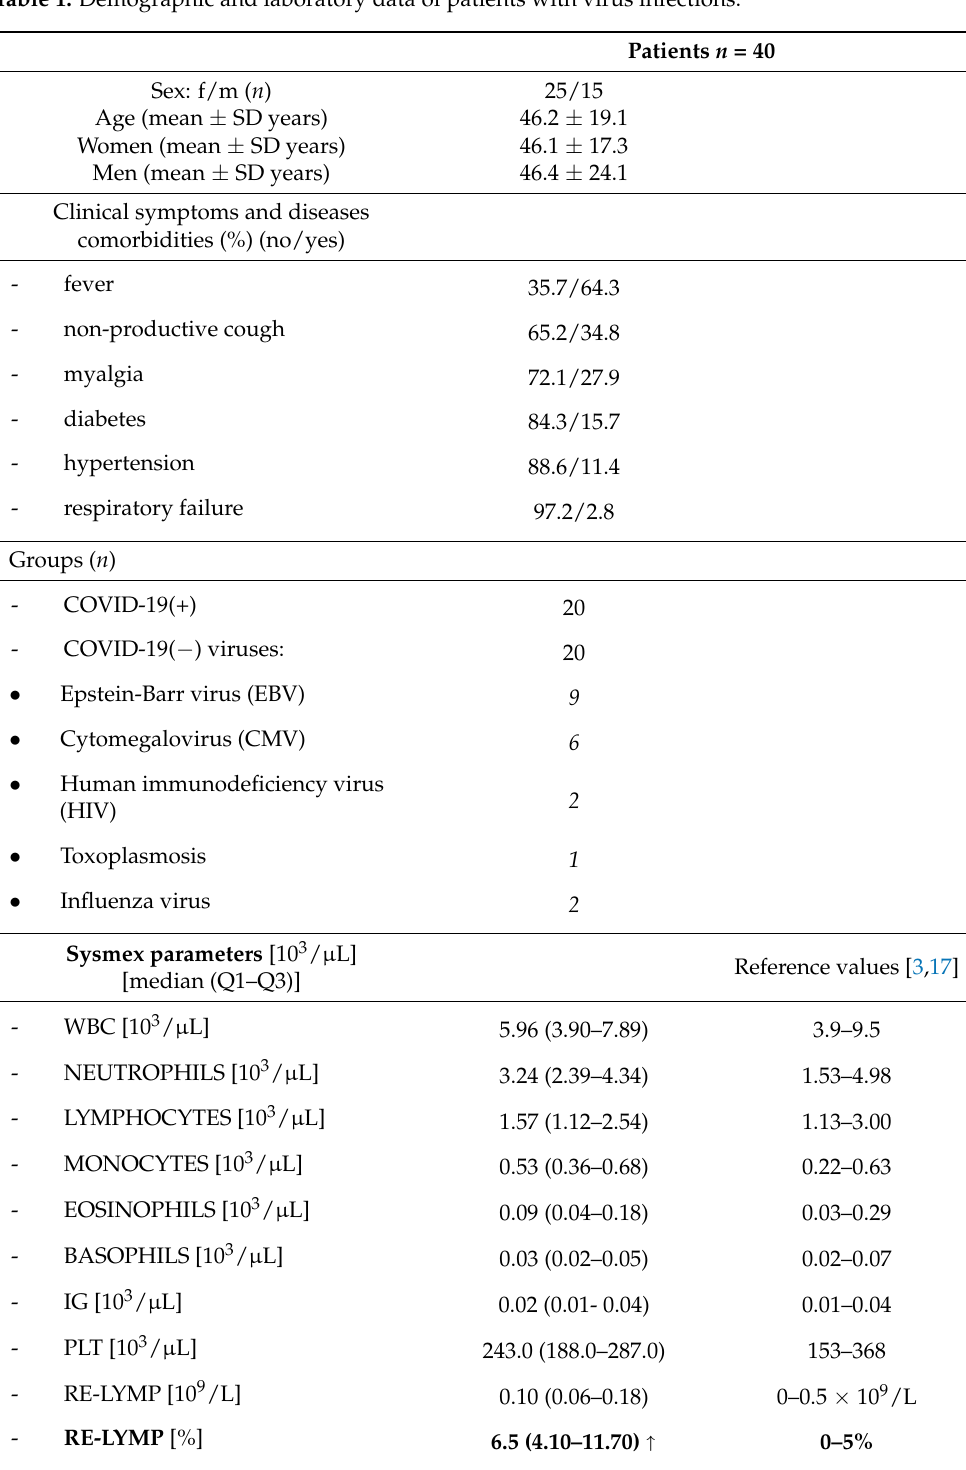
Table 1. Demographic and laboratory data of patients with virus